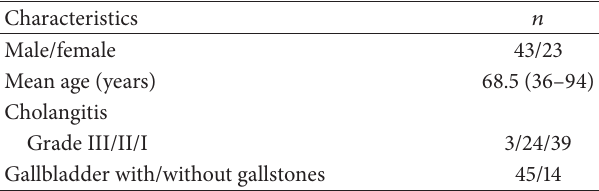
Table 1: Patient characteristics ( 𝑛 = 66 ). Table 2: Stone disappearance ( 𝑛 = 66